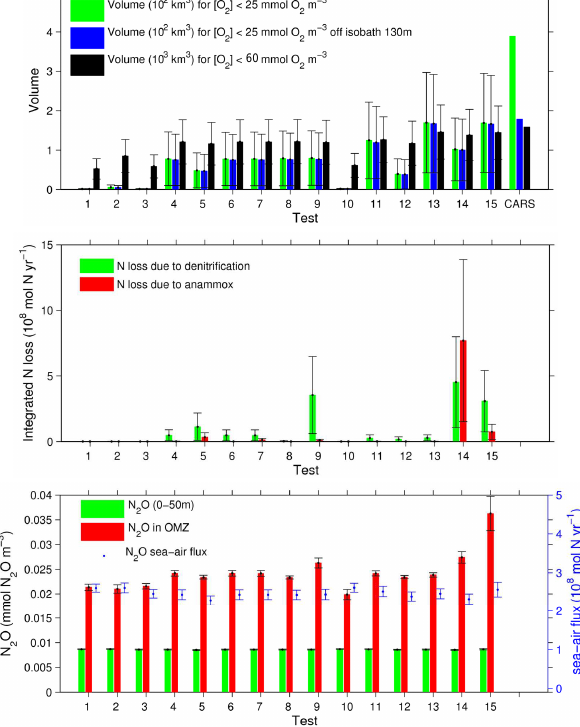
Fig. 13. Top: oxygen volume below 25mmol O 2 m − 3 (10 2 km 3 ; suboxic volume or OMZ volume) and below 60mmolO 2 m − 3 (10 3 km 3 ; hypoxic volume). The same fields using CARS (2006) climatology are added to the right of the histogram. Middle: N loss due to denitrification and anammox processes (10 8 molNyr − 1 ) . Bottom: mean N 2 O concentrations (mmolN 2 Om − 3 ; left axis) in the mixed layer ( ∼ 0–50m) and in the OMZ, and mean N 2 O emis- sions to the atmosphere (10 8 mol N yr − 1 ; right axis). There are 8yr mean values for the different tests realized for the sensitivity analy- ses, computed between 22–24 ◦ S and 10–15 ◦ E. Black (or blue for sea–air flux) bars represent the standard deviation of the 8 annual mean values (Y12–Y19) for these different